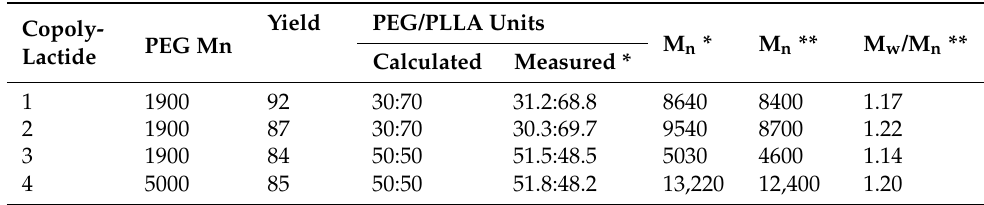
Table 1. Molecular parameters for PEG-co-PLLA copolylactides (BHP was used in an equimolar amount with respect to PEG